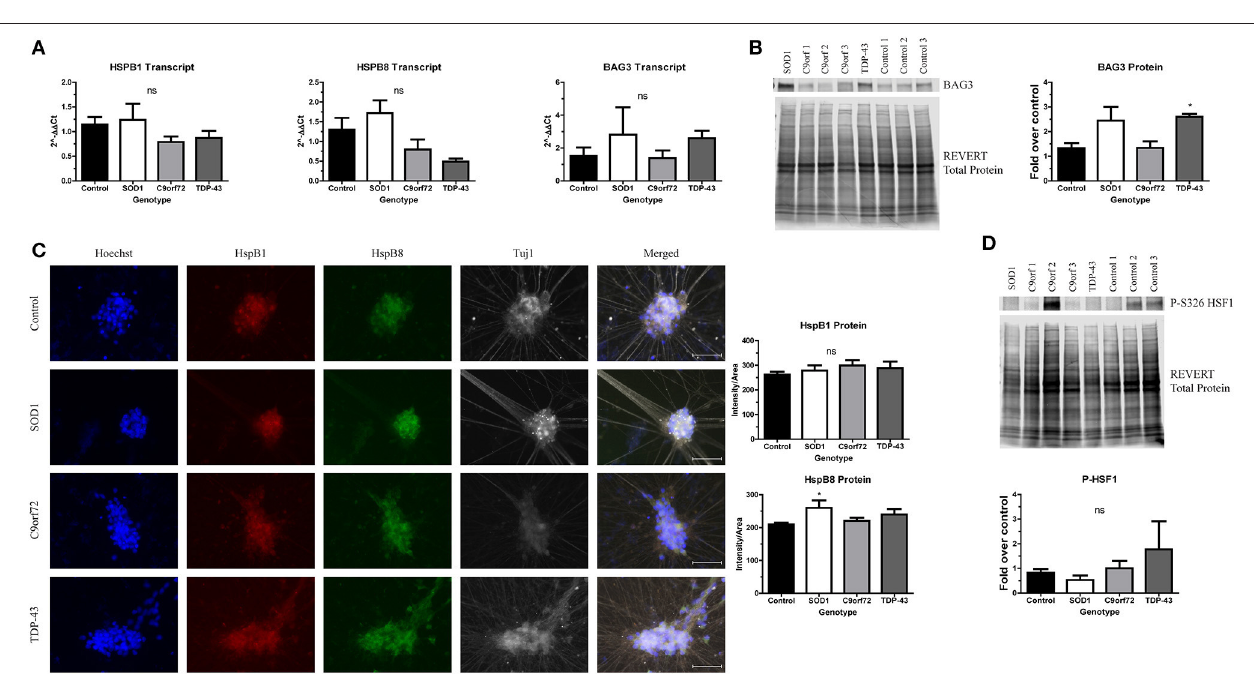
FIGURE 4 | post-hoc test). n = 3, scale bar = 10 µ m (full image) or 2 µ m (expanded). (B) Total protein levels of OPTN are unchanged by Western blot. Data are normalized to REVERT total protein and expressed as a fold change over control (ns, p > 0.05 by one-way ANOVA with Tukey post-hoc test). n = 3. (C) OPTN